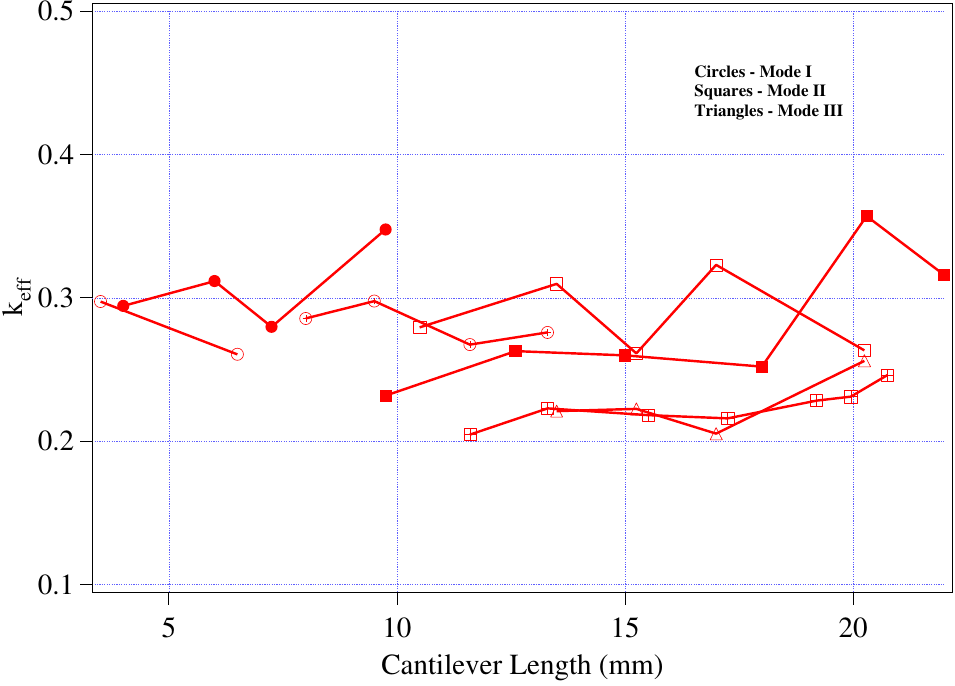
Figure 5 . Effective bending piezoelectric coupling coefficient (k eff ) versus cantilever length. High values between 0.20 - 0.35 occur for all three modes and sustain throughout the range of length